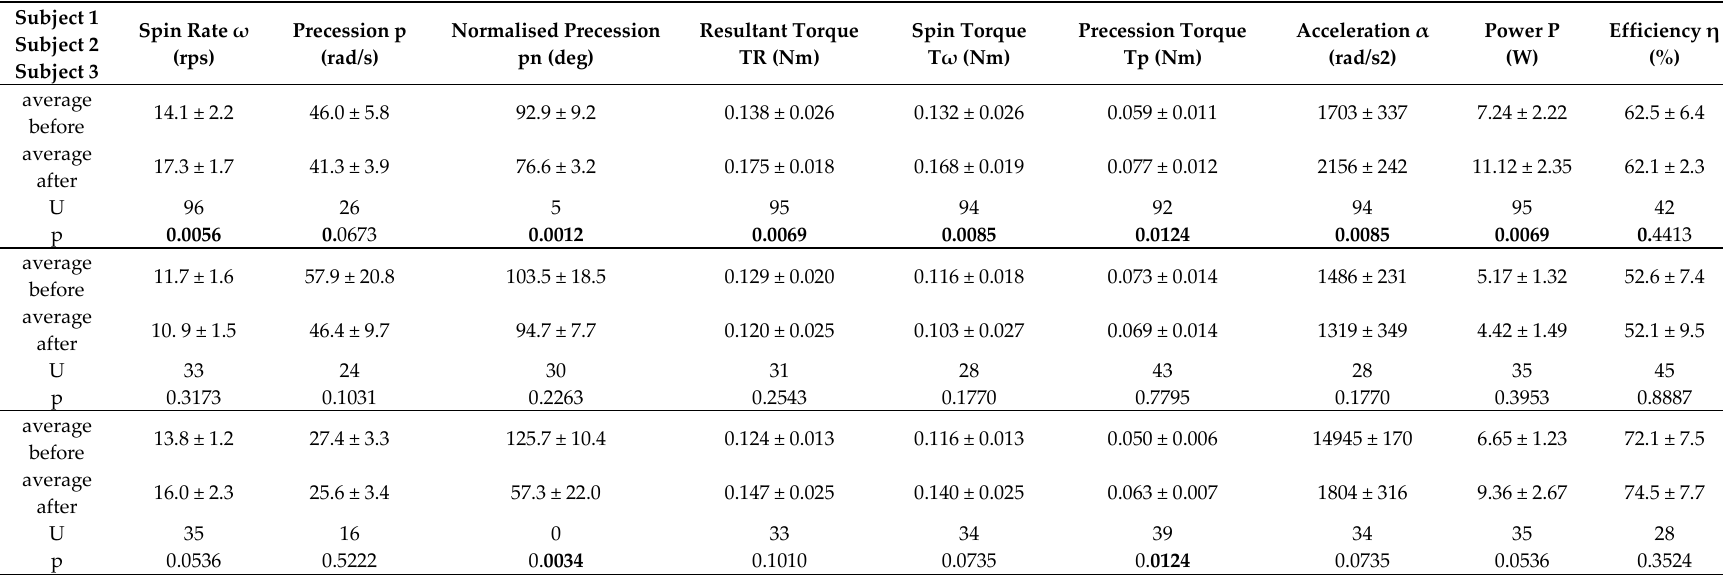
Table 1. Performance data (mean ± standard deviation), of three bowlers before and after intervention, including U and p of Mann-Whitney U-test (note that U and p are unitless); bold font: p < 0.05 (significant